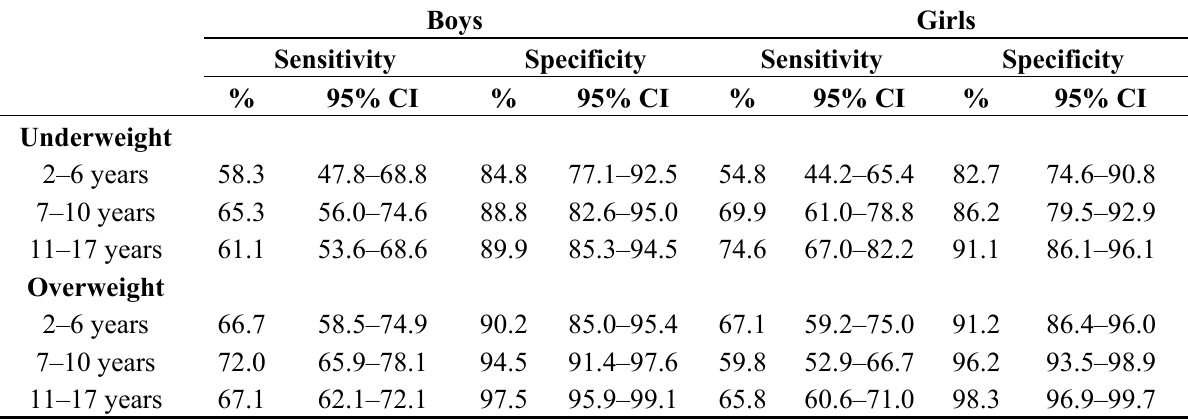
Table 2. Sensitivity and specificity (in percent) for underweight and overweight by sex and age groups. Boys Girls Sensitivity Specificity Sensitivity Specificity % 95% CI % 95% CI % 95% CI % 95% CI Underweight